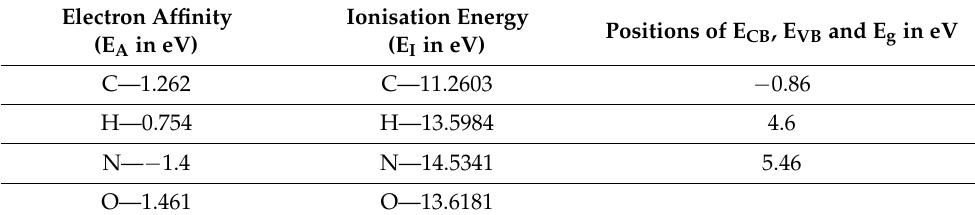
Table 3. Positions of conduction band, valence band and energy gap.